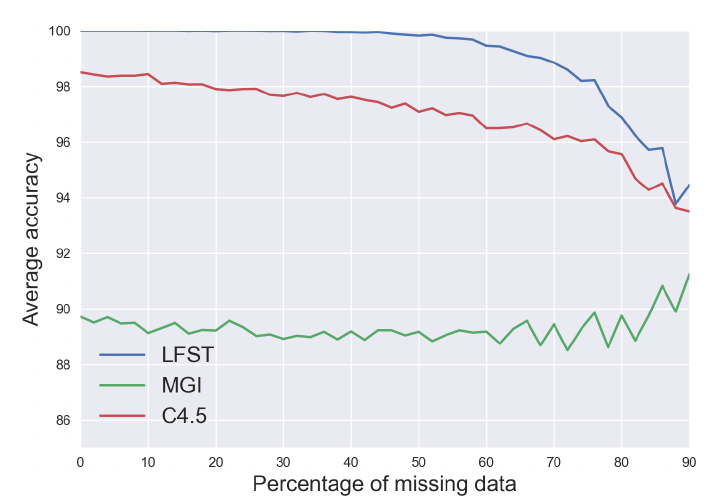
Figure 9. Comparison of the average accuracy in CubeWorld.